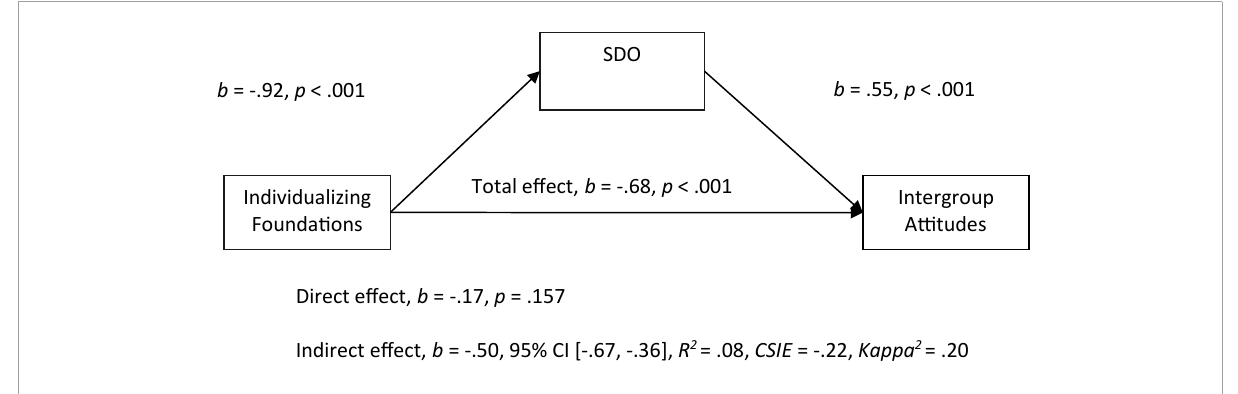
FIGURE5 Mediation model of the relationship between individualizing foundations to intergroup attitudes by social dominance orientation. All betas represent unstandardized values from the Bootstrap analysis with 5,000 samples. CSIE represents the completely standardized indirect